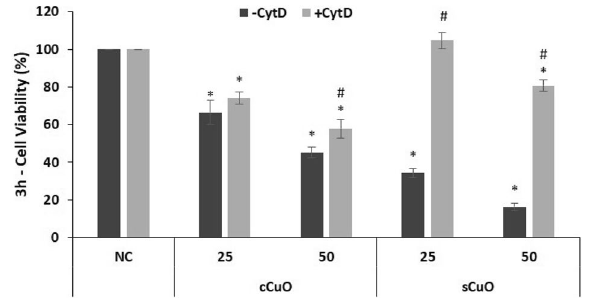
Figure 10. Cell viability results by MTT assay of A549 pre-incubated with an endocytosis inhibitor. Cells were exposed to copper oxide nanoparticles for 3 h after pre-incubation with 4 µM Cytocalasin D (+ CytD, light grey bars) or without pre-incubation (-CytD, dark grey bars). Results are expressed as mean ± SD. *Significantly different from the negative control (NC) (ANOVA + Fisher LSD, p < 0,05). # Significantly different from the correspondent experimental group without inhibitor (t-test, p = 0,002).